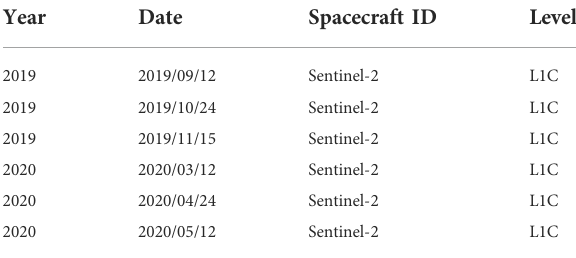
TABLE 1 Description of downloaded Sentinel-2 image data.